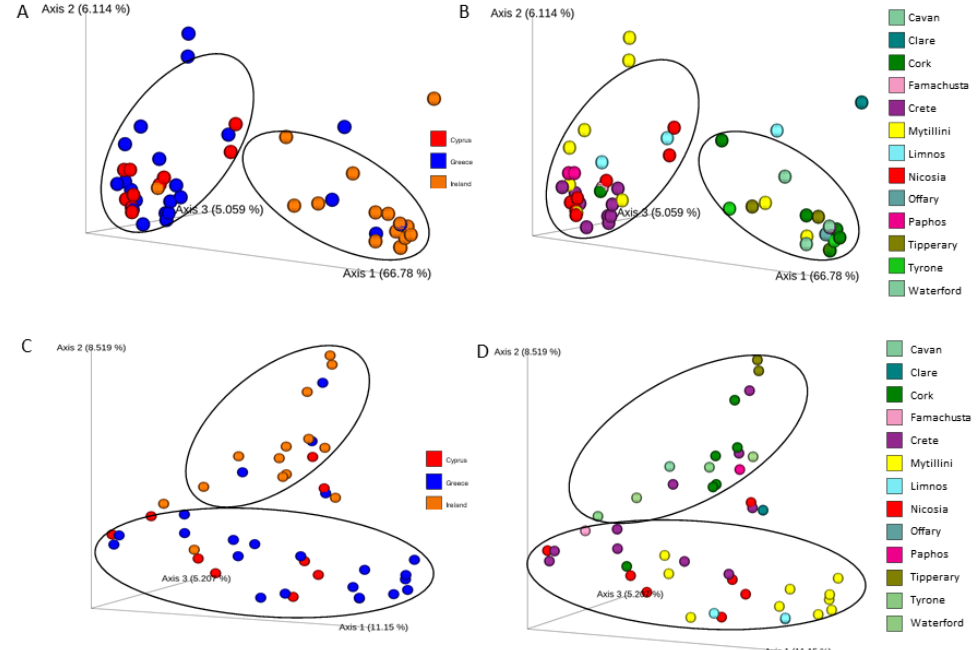
Figure 3. Principal coordinate analysis (PCoA) plot, showing the similarities in microbial beta diversity among cheeses: ( A ) from different countries, regarding bacterial beta diversity; ( B ) from different areas, regarding bacterial beta diversity; ( C ) produced by milk from different animals, regarding bacterial beta diversity; ( D ) from different countries, regarding fungal beta diversity; according to Unweighted Unifrac distance.